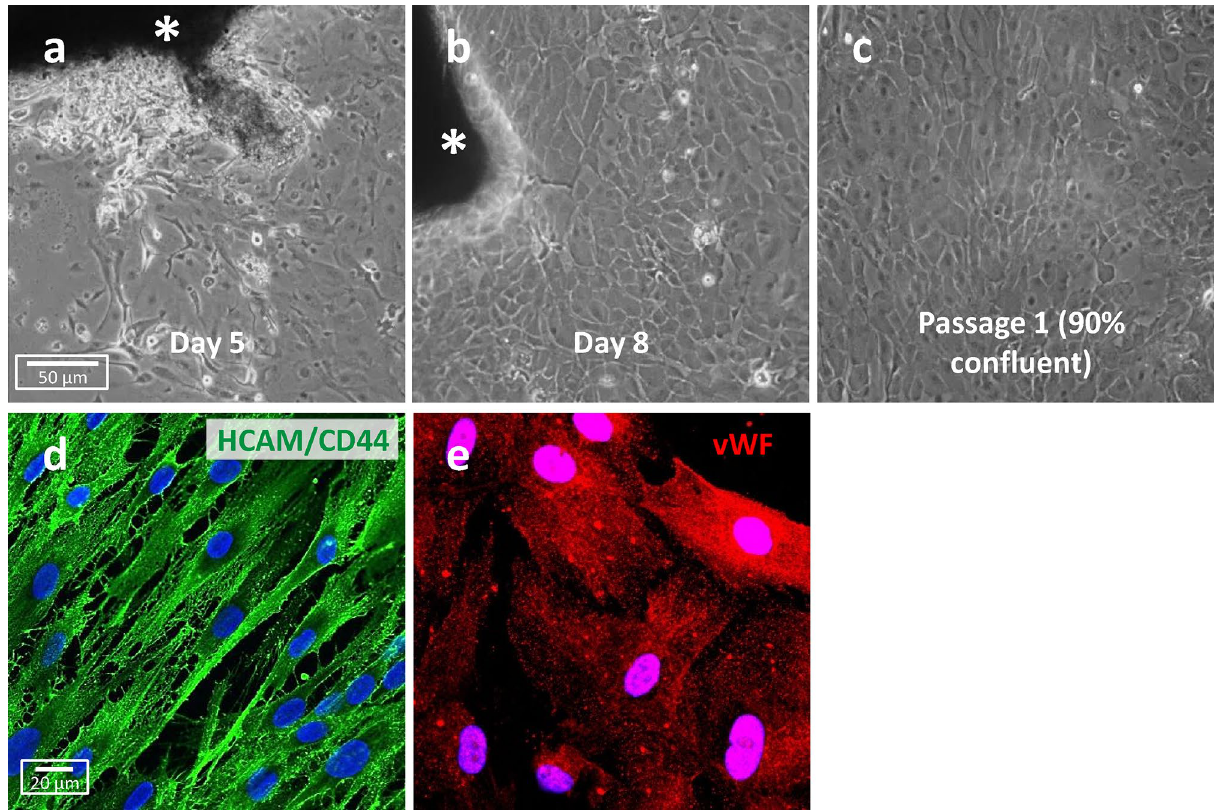
Figure 2. VDOP primary cells. ( a , b ) Gross morphological characteristics of VDOP cells growing out of tissue removed from the distal outflow region (asterisks). ( c ) Primary cell line of VDOP cells at 90% confluence. ( d ) VDOP cells stain positive for HCAM/CD44, highlighting the intercellular processes. ( e ) VDOP cells also show strong localization of von Willebrand factor (vWF), indicating a possible endothelial lineage of the cells. Representative images from VDOP cells at passage 4. Scale bar, 50 µm ( a – c ); 20 µm ( d , e